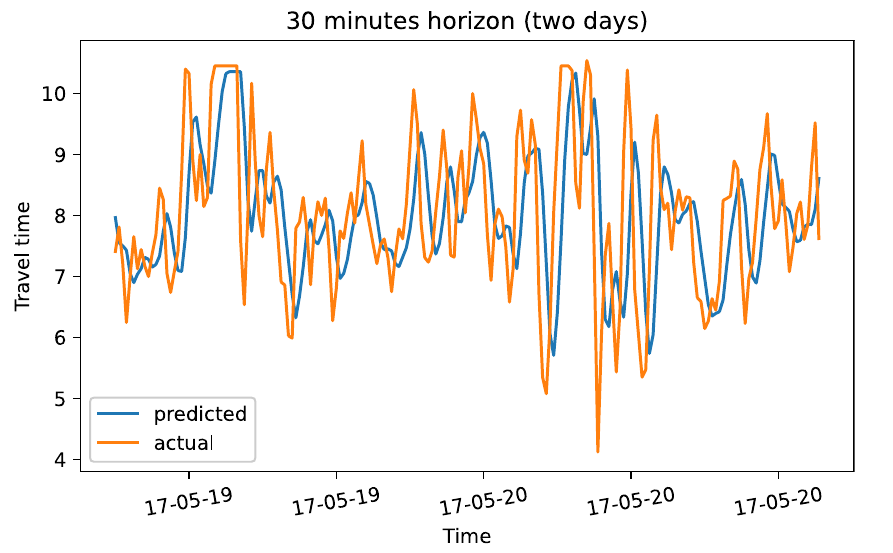
Fig 9. Prediction results for 30 minutes horizon on test data (two days).